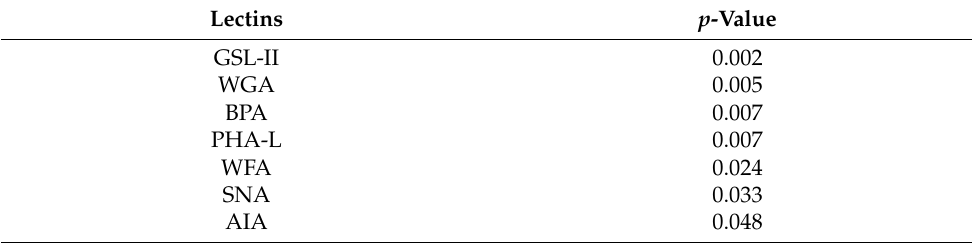
Figure 5. GLYcoPROFILE ® Heat Map representation of the fluorescence intensities of raw data of individual SARS-CoV-2-positive (from N ◦ 1 to 39) and -negative samples (from N ◦ 40 to 45). ( A ) GLYcoPROFILE ® Heat Map with indicated viral charges (red arrow: high viral load, blue arrow: moderate viral load, no arrow: viral load not determined); ( B ) Regrouped GLYcoPROFILE ® Heat Map according to increasing (moderate to high) viral charge. Interpretation of viral charge results for N gene amplification of SARS-CoV-2 virus according to FMS: high < 25, moderate 25–30, low > 30. Table 2. Statistical analysis t -test for SARS-CoV-2-positive and -negative samples. Only the positive samples with high viral charge < 25 were taken for the calculation. The p -value under 0.05 can be considered as